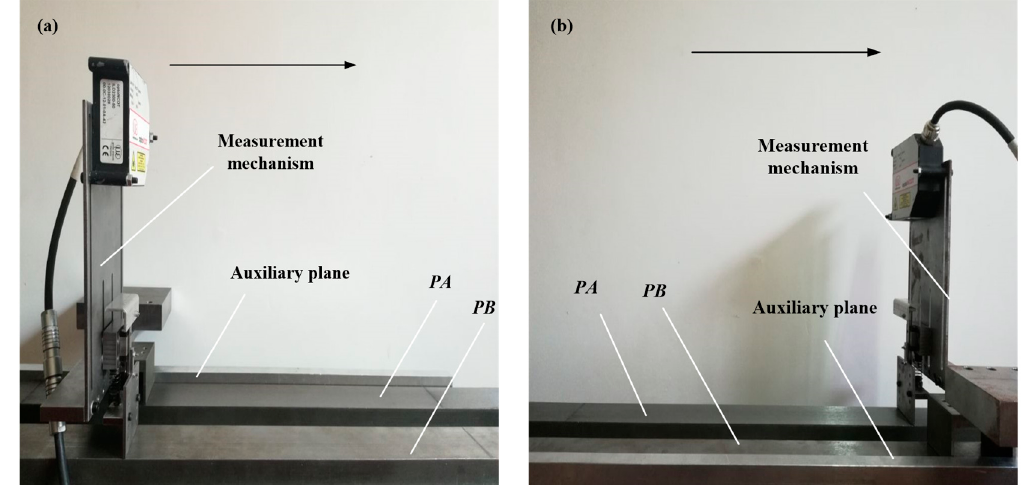
Figure 15. Measurement system of two horizontal parallel surfaces. ( a ) PB is the measured surface. ( b ) PA is the measured surface.